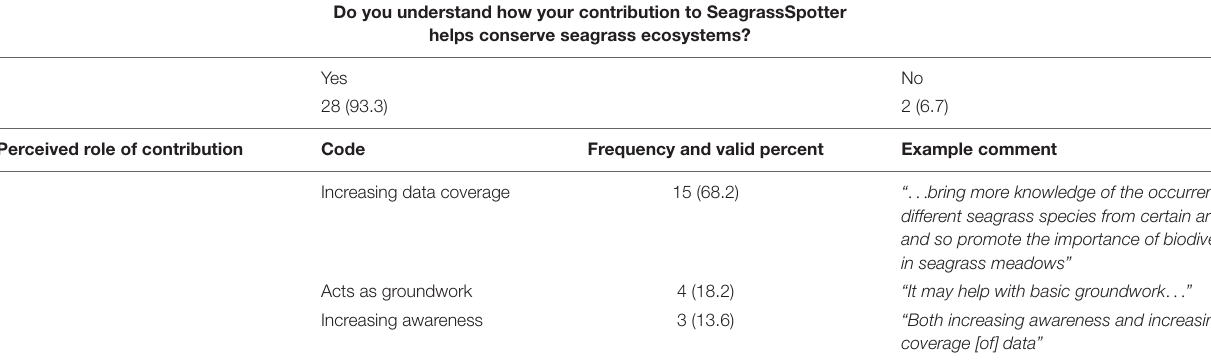
TABLE 10 | Perceptions of how contributing to SeagrassSpotter helps to conserve seagrass